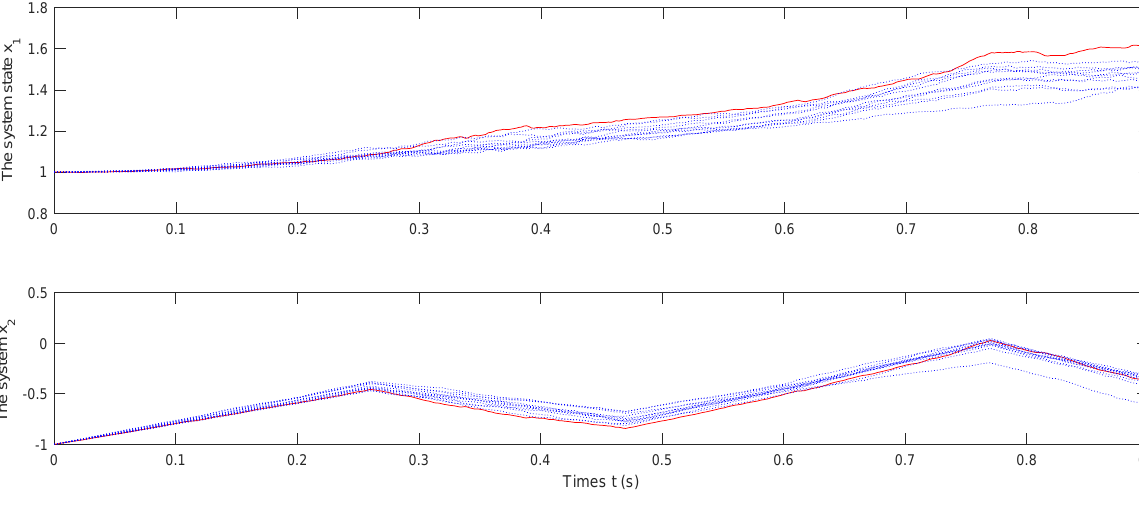
Figure 6. The trajectories of states x 1 ( t ) and x 2 ( t )